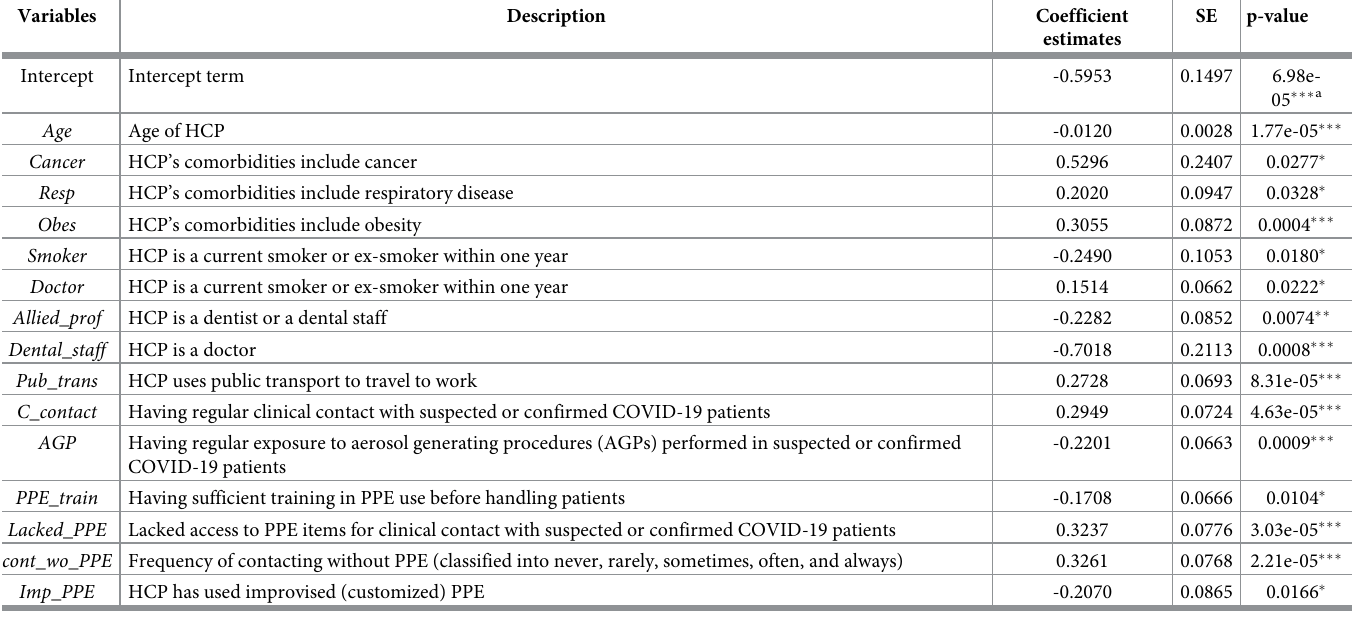
Table 2. Estimated coefficients and their statistical significance for the multivariate logistic regression